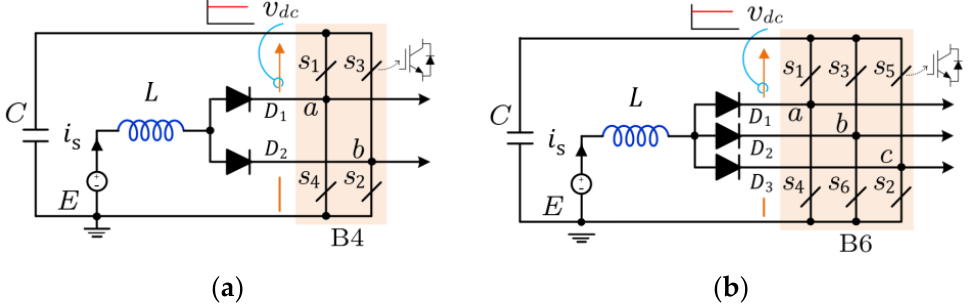
Figure 3. Basic SSI topology, ( a ) single-phase SSI [15], and ( b ) three-phase SSI [16].